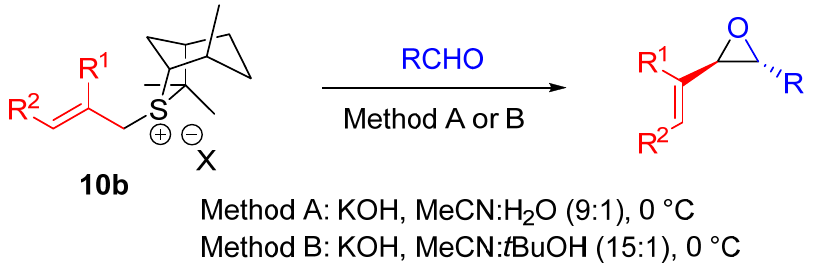
Table 3. Aggarwal asymmetric synthesis of vinyl epoxides using allyl sulfonium salt (Scheme